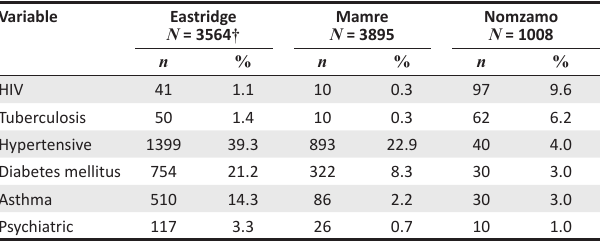
TABLE 2: Proportion of population identified as taking medication for chronic conditions.